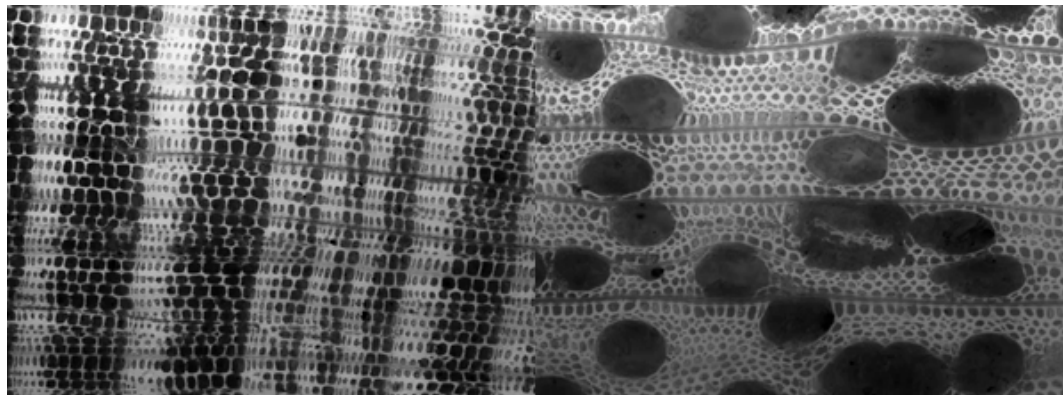
Figure 9. Transmitted light images of a typical softwood (spruce) and hardwood (poplar).